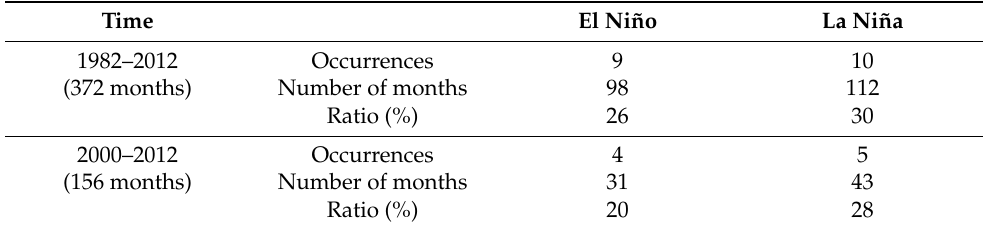
Table 4. Occurrences and durations of ENSO